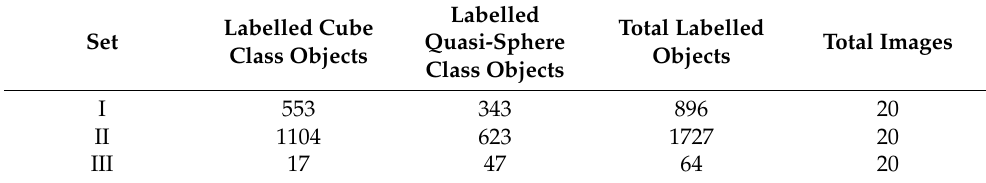
Table 4. Validation datasets used to evaluate the performance of the trained